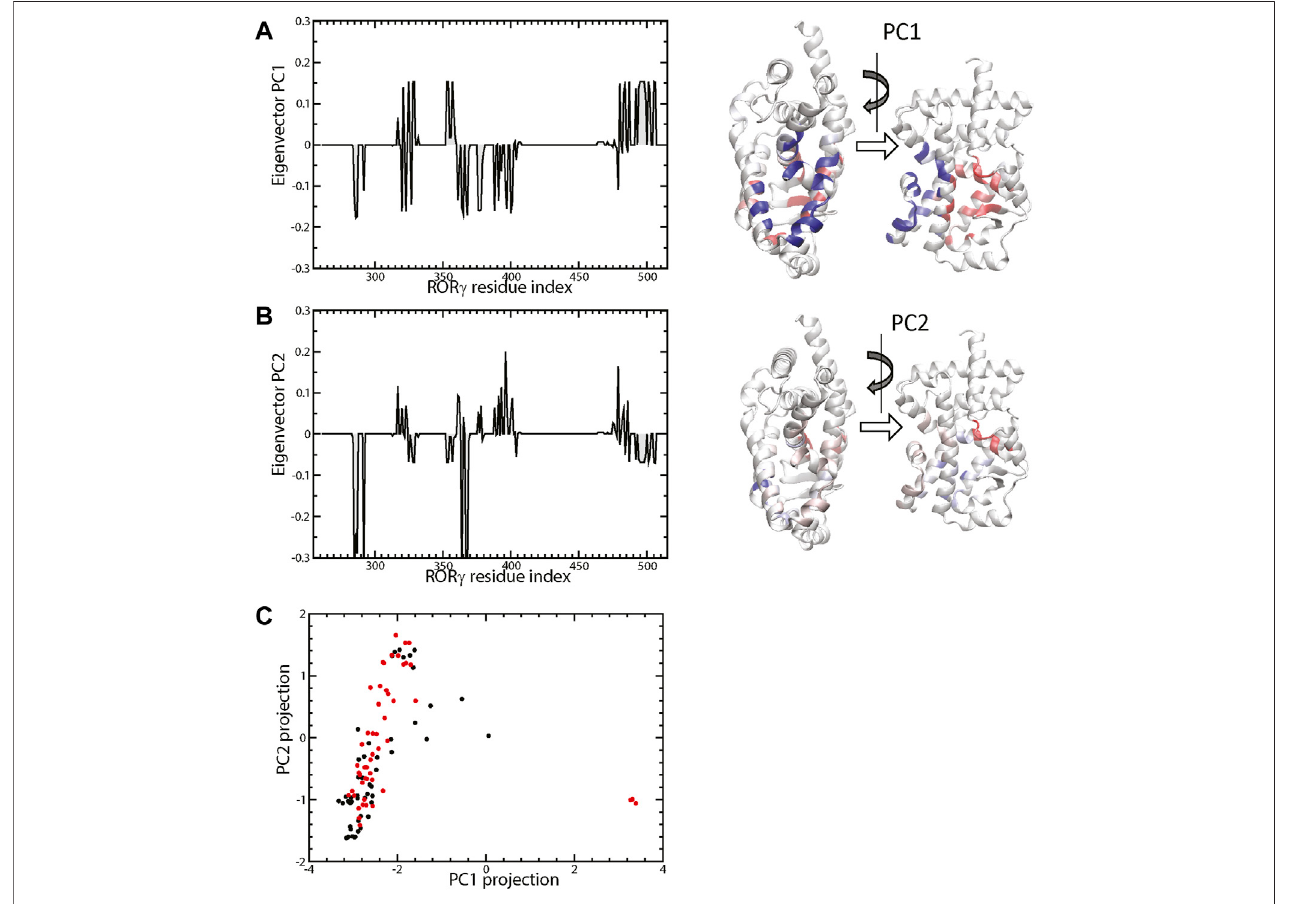
FIGURE 4 | The top two eigenvectors PC1 and PC2 are shown in (A , B) , respectively. The 3D representations are colored by the elements of the corresponding eigenvectors(blue+andred − ).Theprojectionofprotein-ligandinteractionfromthetoptwoPCsofthe132structures(activelabeledinblackandinactiveinred)isshownin (C) .